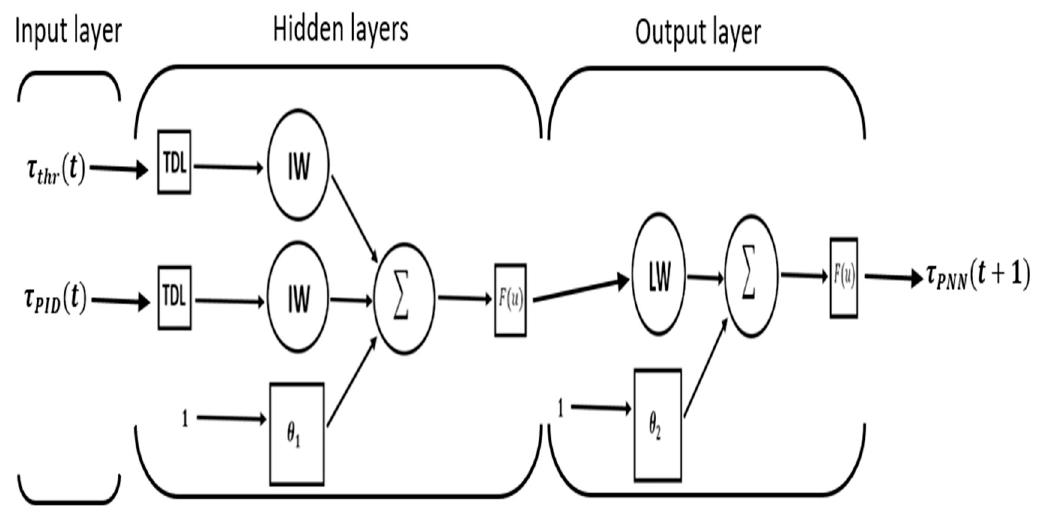
Figure 8. Predictive Neural Network (PNN) model structure.